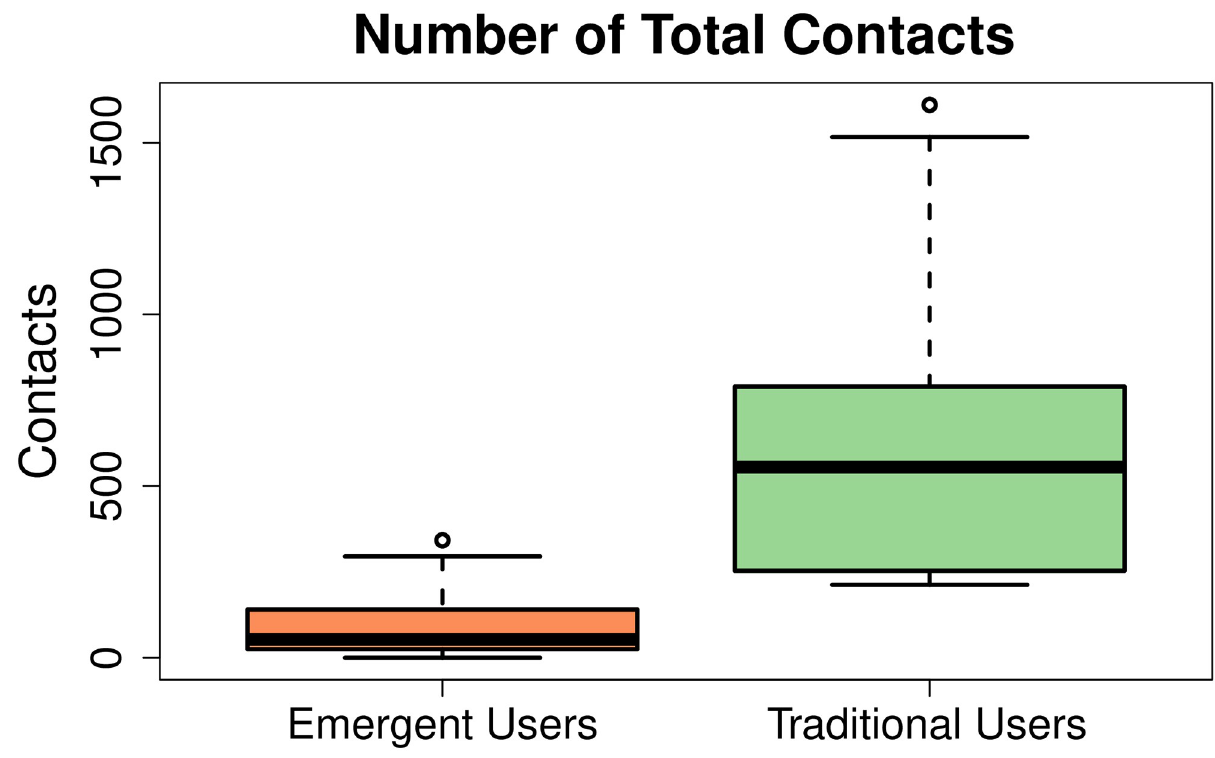
Fig 5. Comparison of total number of contacts between traditional and emergent smartphone users. Emergent users had very few number of total contacts as compared to traditional user. The mean number of emergent users’ contacts came out to be 100.9% (s.d 94%) whereas, traditional users had a mean number of 609% (s.d 385%)